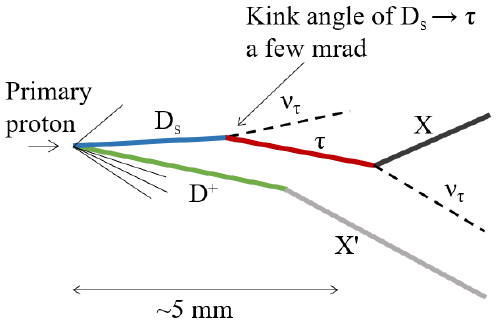
Figure 1. Ds to tau decay topology [5].